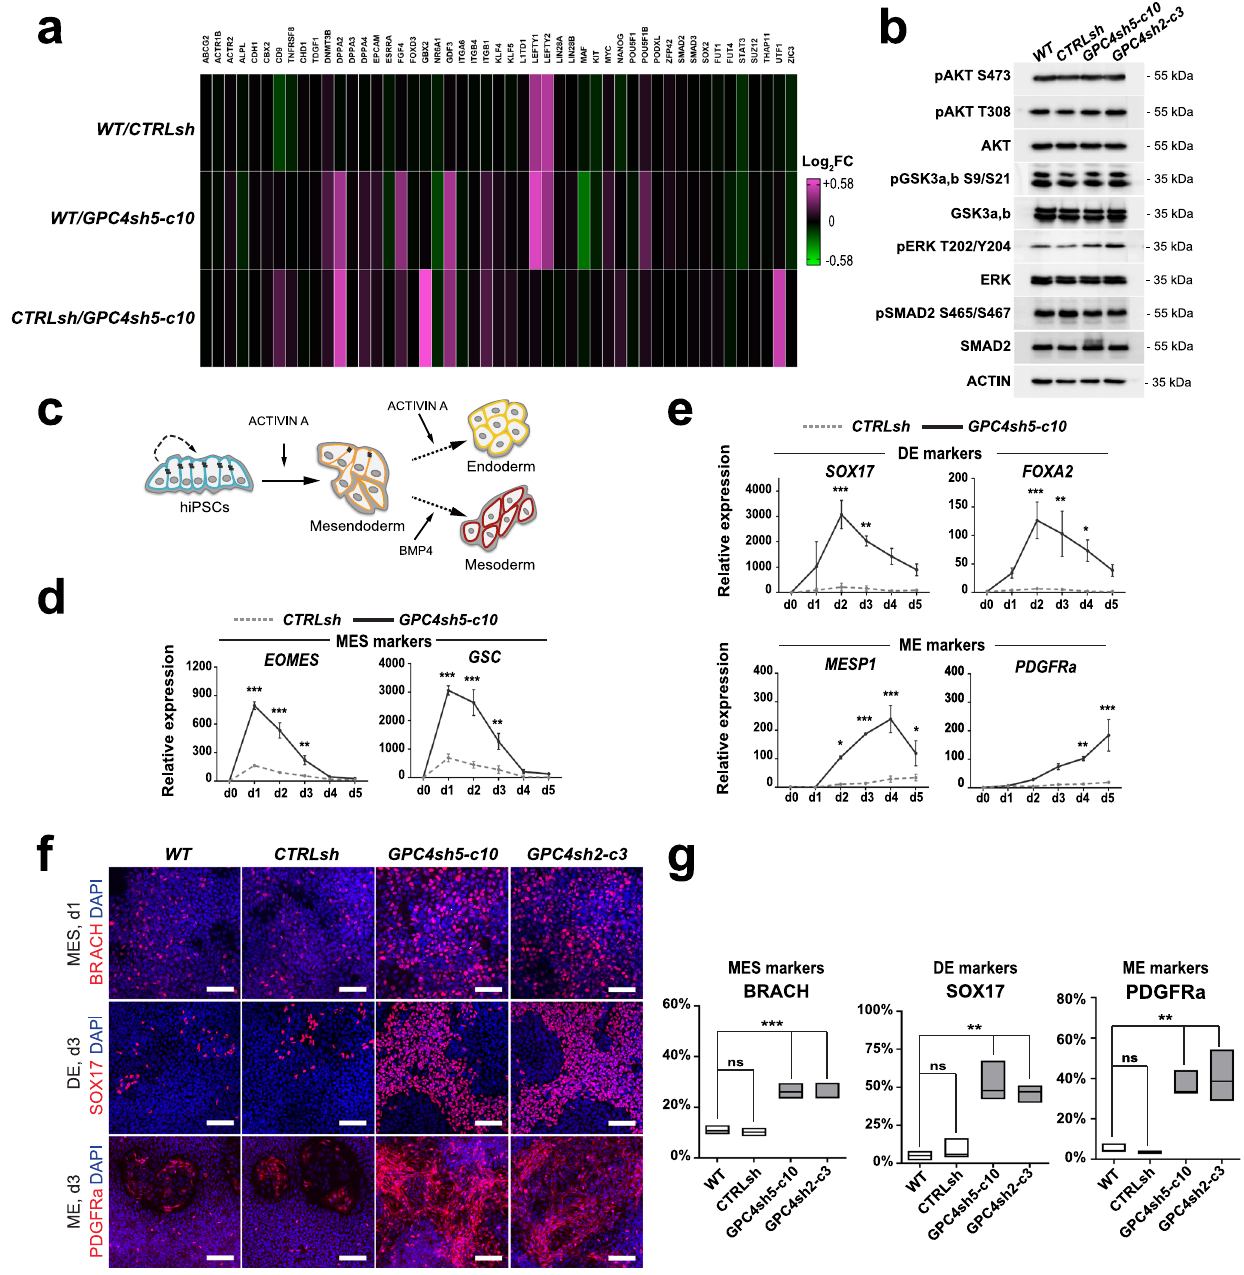
Fig.2|Disruptionofepithelialintegritydoesnotaffectstemnesspropertiesof hiPSCs but enhances differentiation potential. a Transcript levels of genes reg- ulating pluripotency were analyzed by RNA-seq in WT, CTRLsh and GPC4sh5-c10 029 hiPSCs at the undifferentiated stage. Data are represented as a heatmap of Log 2 FC, n =3. b TotalproteinextractofWT,CTRLsh,GPC4sh5-c10andGPC4sh2-c3 029hiPSCsattheundifferentiatedstagewereanalyzedbyWestern-blotwithpAKT S473, pAKT T308, AKT, pERK T202/Y204, ERK, pGSK3a, b S9/S21, GSK3a, b, pSMAD2 S465/S467 and SMAD2 antibodies. Note similar expression and phos- phorylation levels of AKT, ERK, GSK3a, b and SMAD2 proteins in all hiPSC lines. ACTIN protein levels were used as loading control, n =3. Blots were processed in parallel. c Scheme depicting the strategy of differentiation into MES and subse- quently into DE and ME used. d , e CTRLsh and GPC4sh5-c10 029 hiPSCs were differentiated for 5days into DE or ME and transcript levels of MES, DE or ME speci fi c markers were analyzed by RT-qPCR. d MES markers ( EOMES and GSC ),